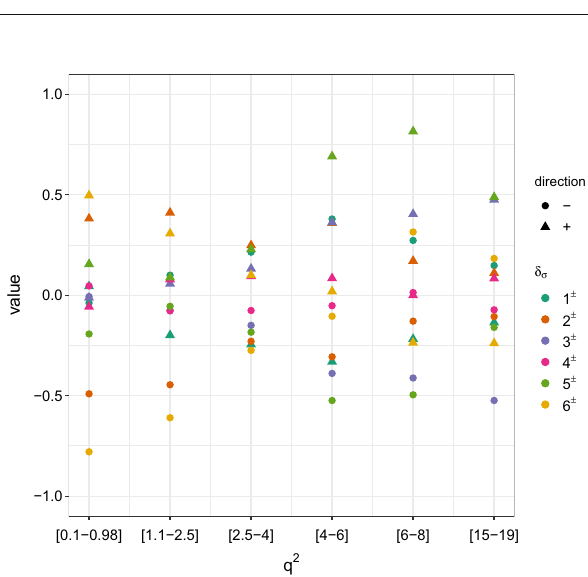
observable at LHCb in different 5